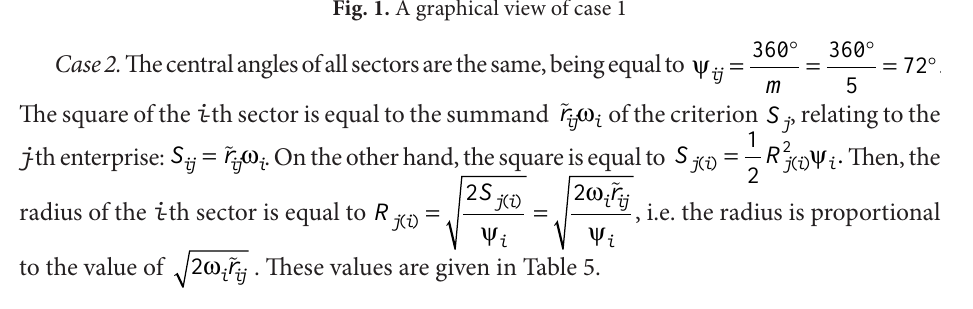
Table 5. The values of the radii of the sectors